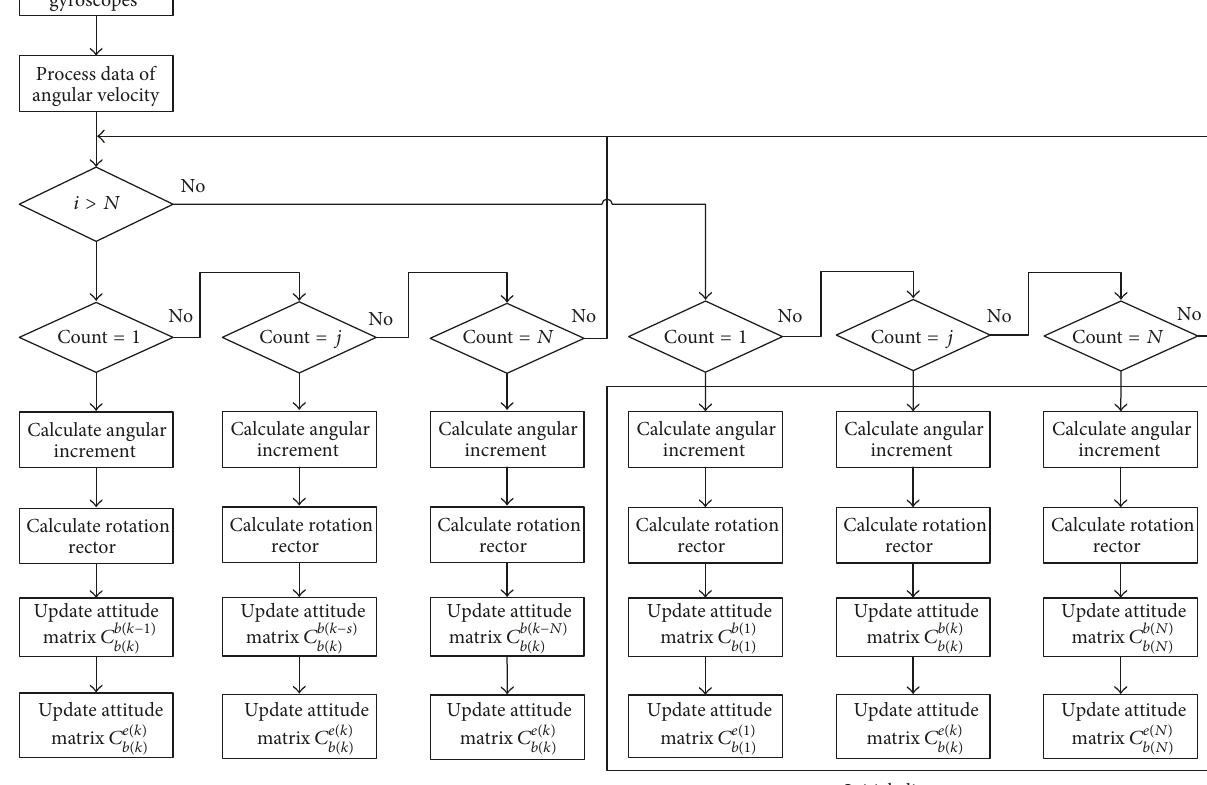
Figure 4: Flow diagram for a Matlab program.